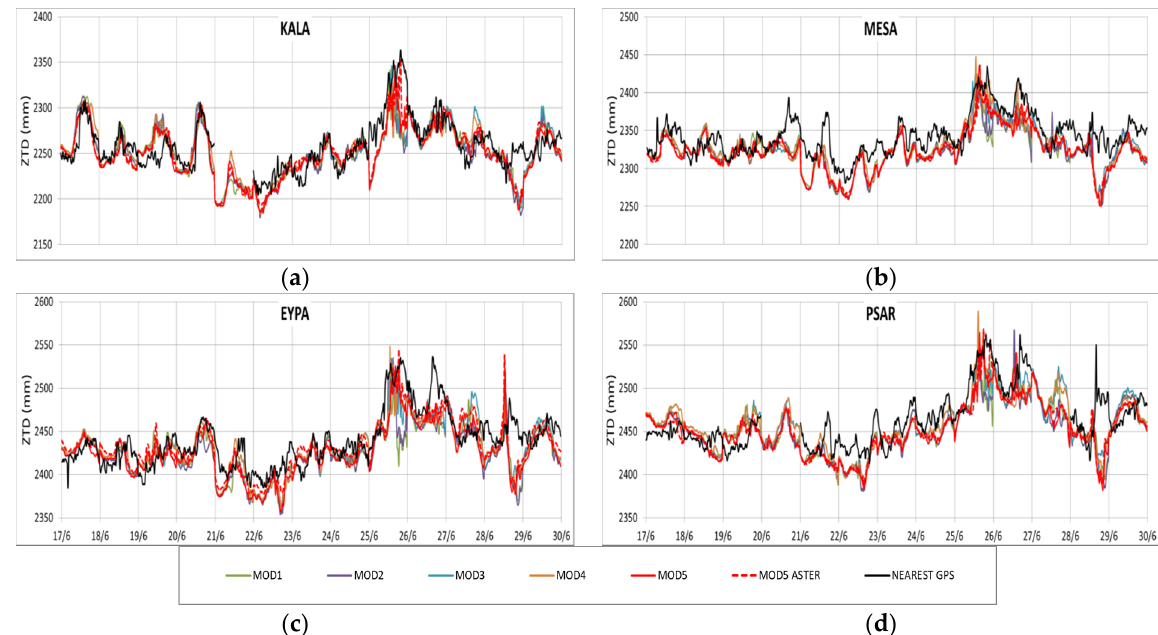
Figure 3. Observed and simulated time series of WRF MOD1-MOD5 vs. GNSS ZTDs at 4 PaTrop stations, KALA ( a ), MESA ( b ), EYPA ( c ) and PSAR ( d ) over the test period (17–29 June 2016).